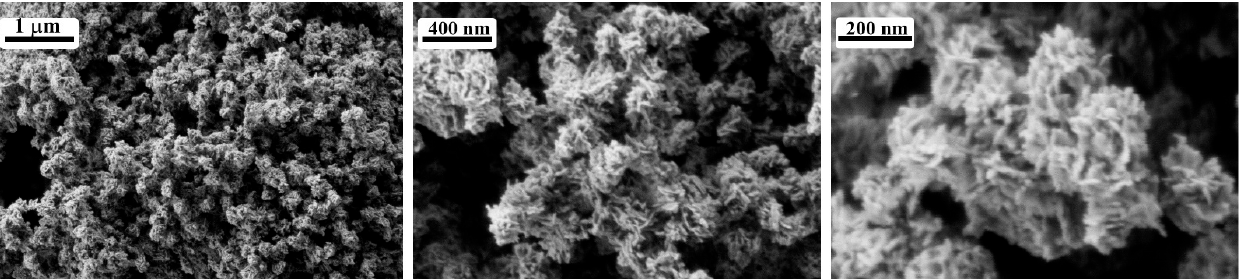
Figure 3. SEM results for oxide powder after annealing at 300 ℃ .